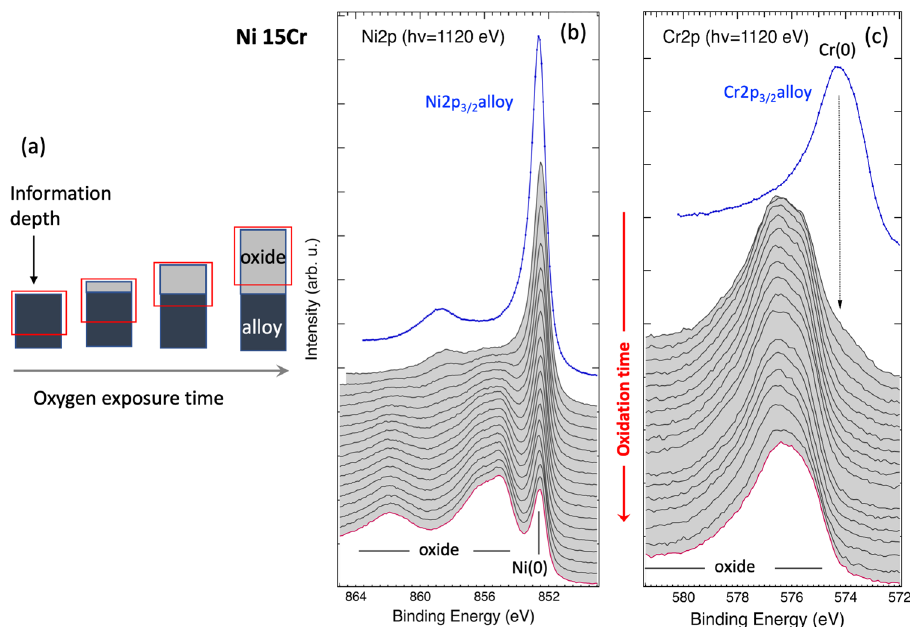
Fig. 2 Ni and Cr evolution. a Schematic illustration of the experiment progression. The information depth window for XPS moves away from the alloy-oxide interface over time. Signal attenuation of the alloy is therefore a signature of oxide growth and growth mode. b Ni 2p 3/2 , and ( c ) Cr 2p 3/2 core levels as a function of oxidation time – the spectrum in blue is the pristine alloy immediately before start of the oxidation